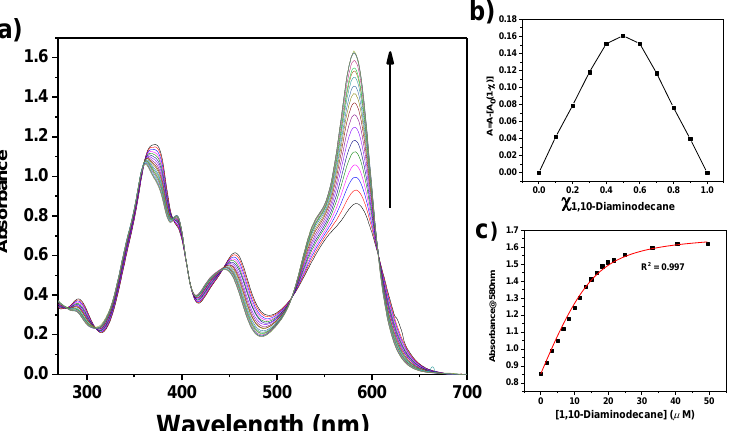
Figure 1. ( a ) Optical absorption titration curves of 1 (15 µM solution in CHCl 3 ) with addition of 1,10-diaminodecane. The concentration of 1,10-diaminodecane added varied from 0 to 50 µM. ( b ) Job’s plot for the binding of 1 with 1,10-diaminodecane. The total concentration of 1 and 1,10-diaminodecane is 15 µ M. ( c ) Variation of the absorbance at 580 nm as a function of the concentration of 1,10-diaminodecane added and fit of the binding isotherm with Equation (1) (red